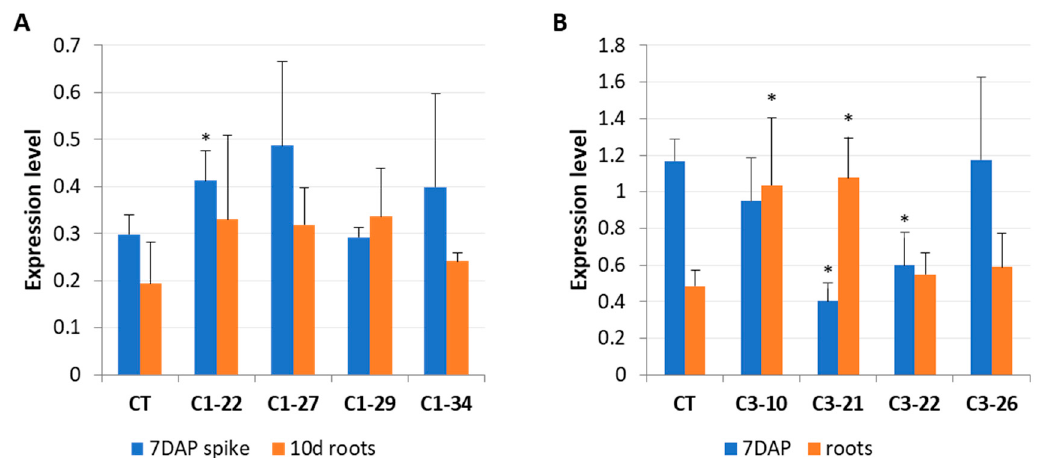
Figure 4. Expression levels of wild-type HvCKX3 in ckx1 mutant lines ( A ) and wild-type HvCKX1 in ckx3 mutant lines ( B ). The transcript accumulation was analyzed in seven DAP spikes and 10-day-old roots. CT, control plants; values are mean ± SD (Table S6, S7); significantly different from control at * p < 0.05. The expression levels were calculated from three technical replicates according to the standard curve methods using the Elongation factor 2 gene as a normalizer. The analysis was performed for three biological replicates.